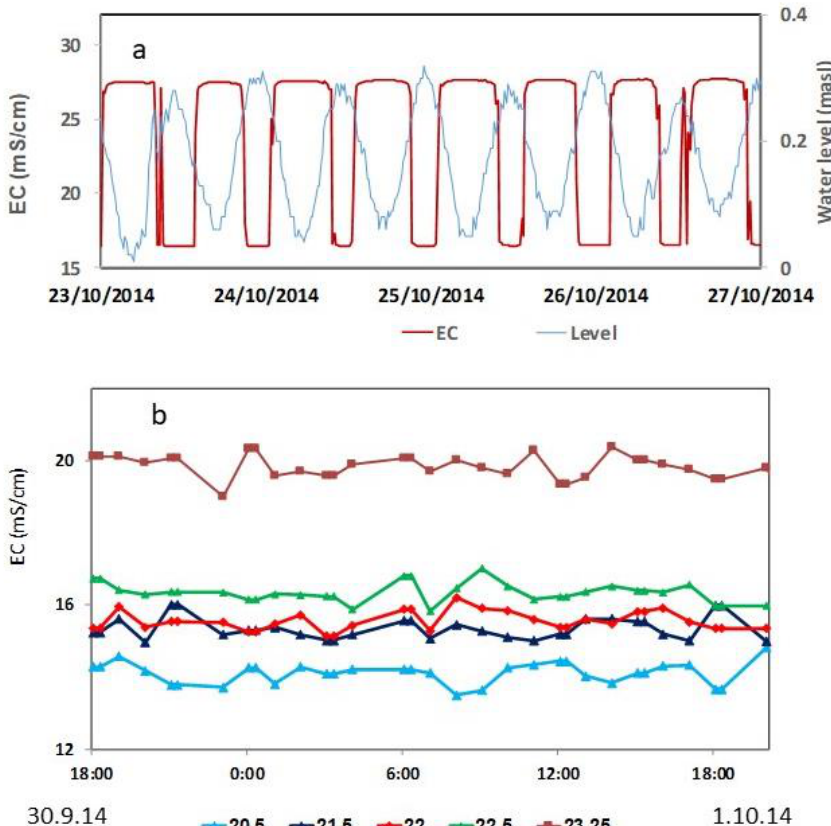
Figure 13. CTD ( a ) and SMD ( b ) measurements. The CTD indicating the e ff ect of sea tide on in-borehole EC fluctuation. Measurements of SMD are from well 71-2 at depths 20.5–23.25 m, with 1-h frequency. CTD located in well 72 at depth 22 m, with 0.5-h frequency.